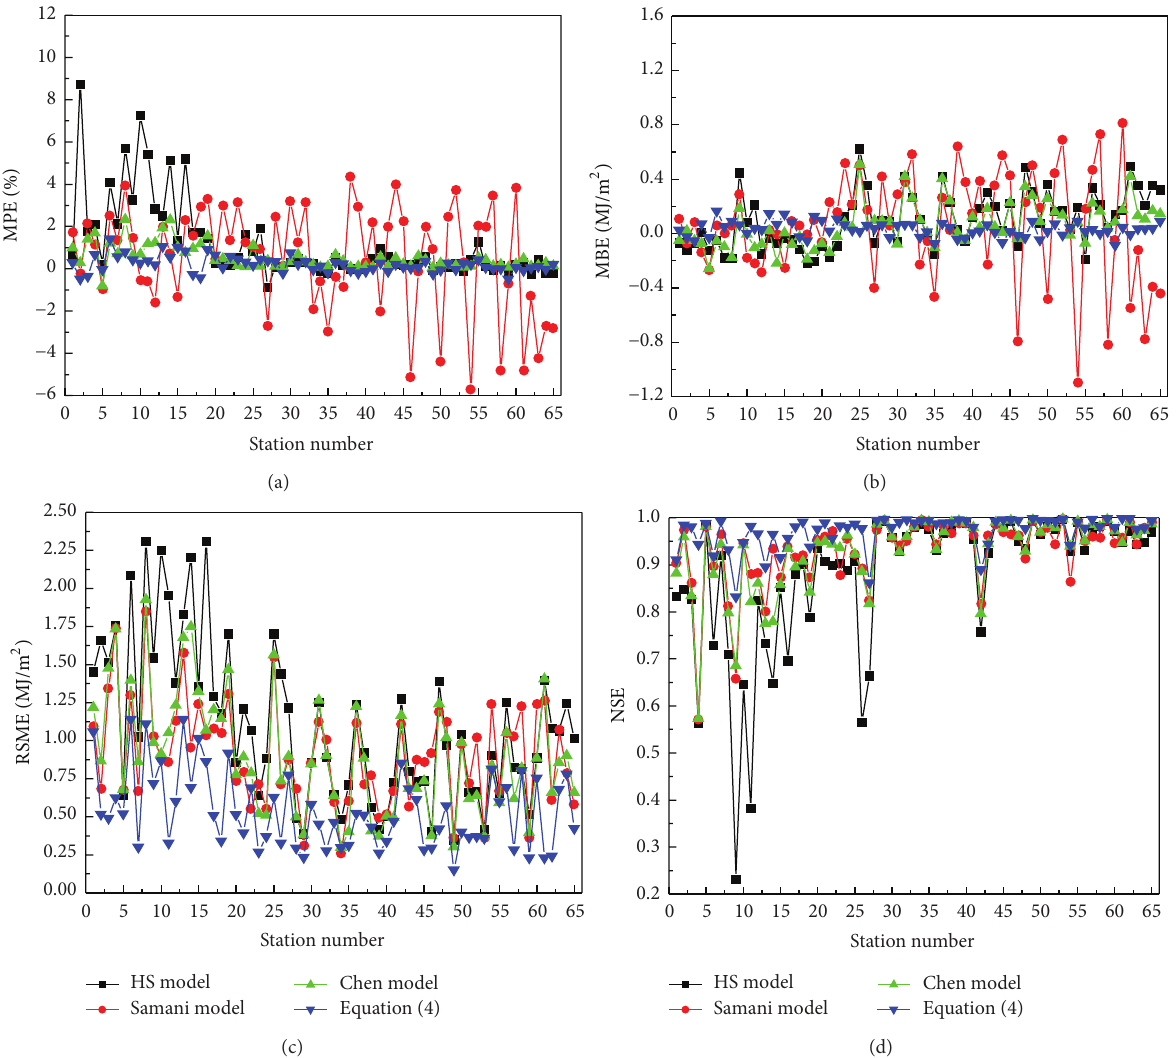
Figure 1: Statistical performance of the four models at the 65 stations (nos. 1–27 in the humid region, nos. 28–43 in the semihumid region, nos. 44–54 in the semiarid region, and nos. 55–65 in the aid region). average values of these statistical indicators are summarized in Table 3. Figure 1 shows that the performance of these temperature-based models improves with Δ𝑇 in general, except for the Samani model in terms of MPE and